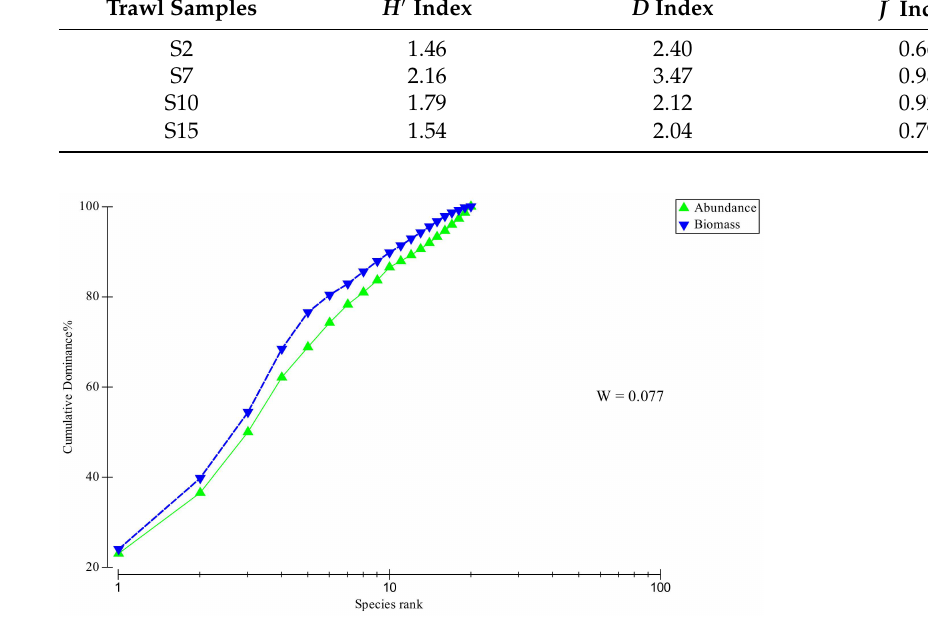
Figure 2. ABC curve of the Jinwan offshore wind farm area.